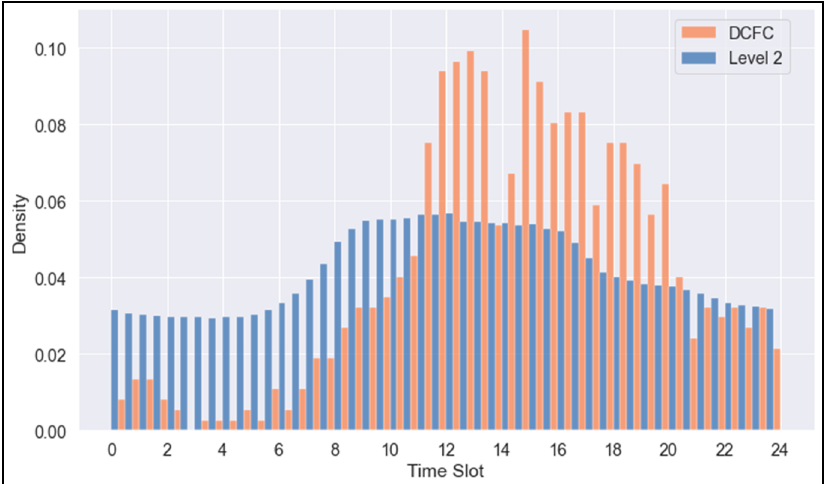
Figure 8. Distribution of DCFC and Level 2 charging station occupation over 30-min time slots.